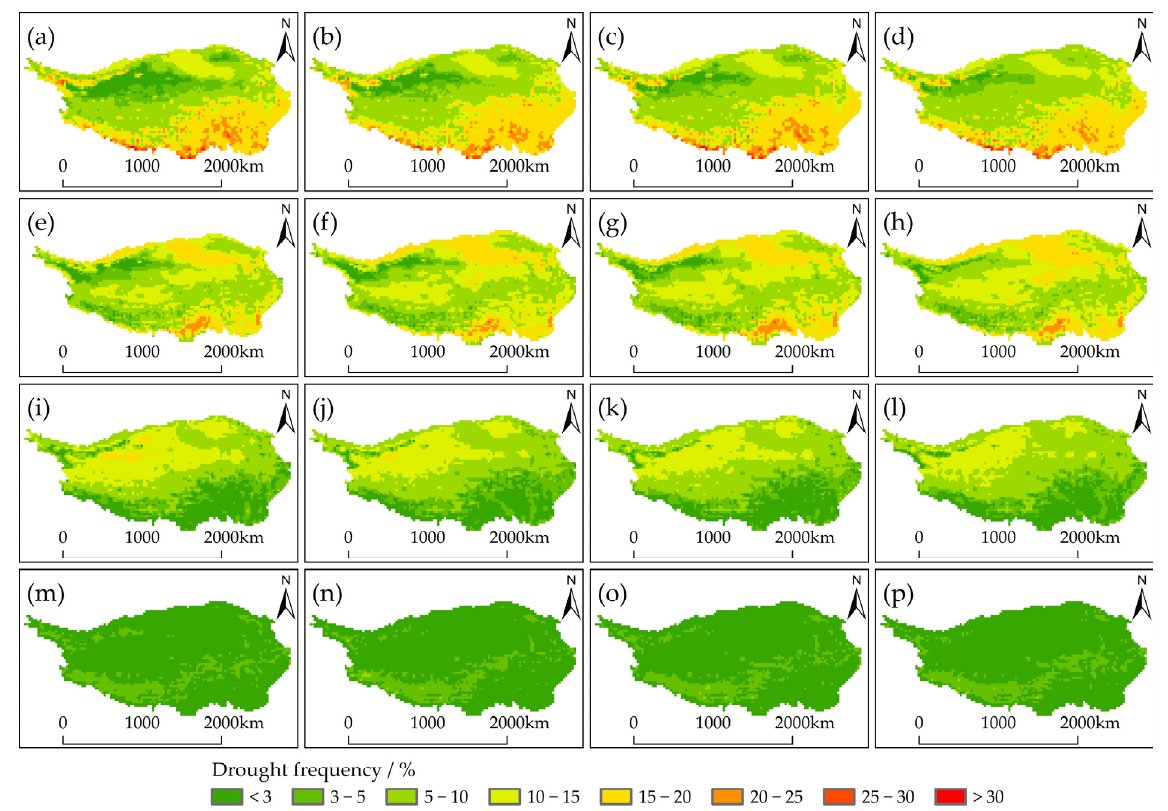
Figure 9. Spatial distributions of the frequency of droughts of various grades on the TP from 2016 to 2099 under four climatic scenarios: Frequency of light drought under the ( a ) RCP2.6, ( b ) RCP4.5, ( c ) RCP6.0, and ( d ) RCP8.5 climatic scenarios; frequency of moderate drought under ( e ) RCP2.6, ( f ) RCP4.5, ( g ) RCP6.0, and ( h ) RCP8.5; frequency of severe drought under ( i ) RCP2.6, ( j ) RCP4.5, ( k ) RCP6.0, and ( l ) RCP8.5; and frequency of extreme drought under ( m ) RCP2.6, ( n ) RCP4.5, ( o ) RCP6.0, and ( p )